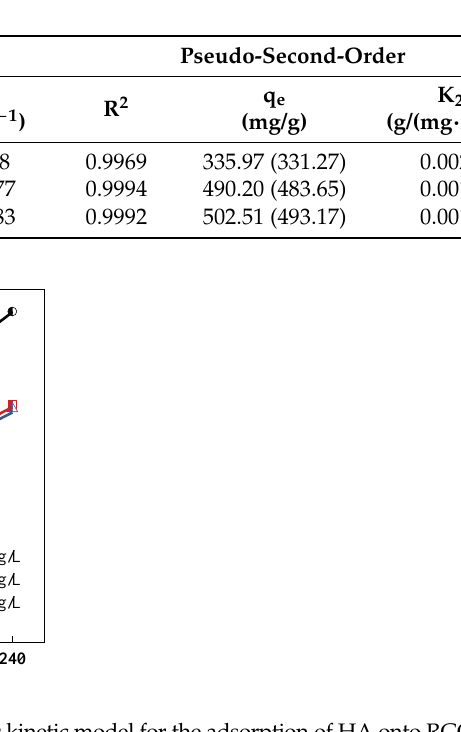
Figure 9. Linear plots of a pseudo-second-order kinetic model for the adsorption of HA onto RGO-SiO 2 Table 1. Comparison of the pseudo-first-order and pseudo-second-order kinetic models for the ad- sorption of HA onto RGO-SiO 2